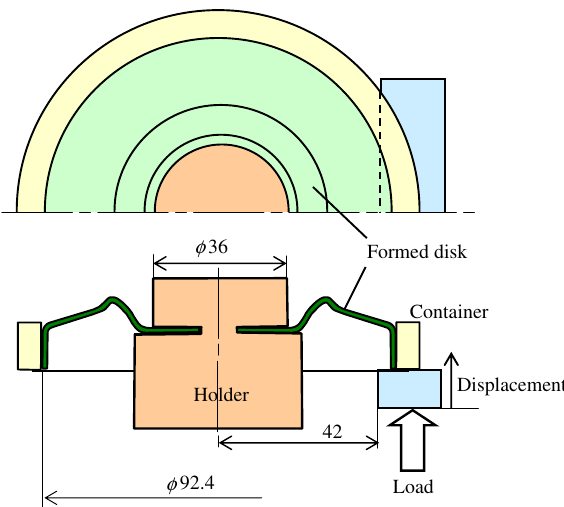
Figure 15. Measurement of bending stiffness of wheel disk formed by six-stage stamping.